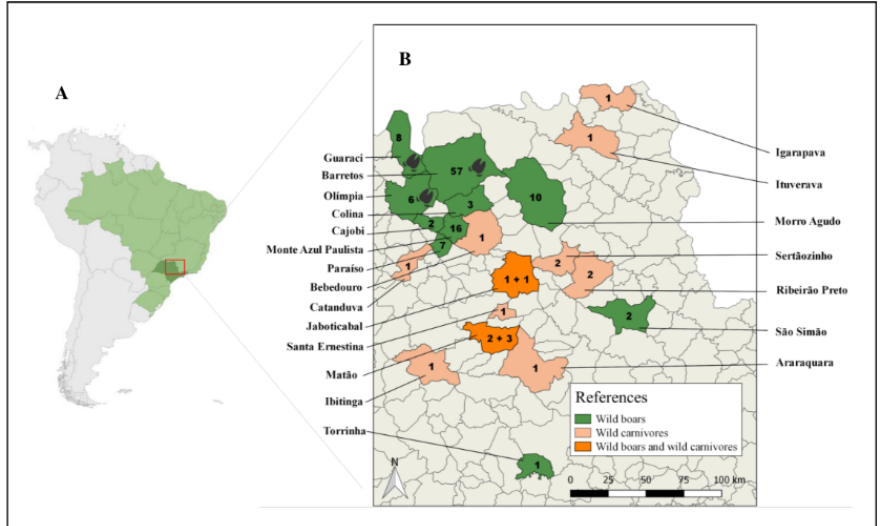
Figure 1. Map of South America ( A ). Location of the study area, distribution of animal groups, and sampled cities in southeastern Brazil ( B ). The numbers indicate the number of animals examined in each city: only wild boars, wild boars and wild carnivores, and only wild carnivores. The symbol represents cities with seropositive wild